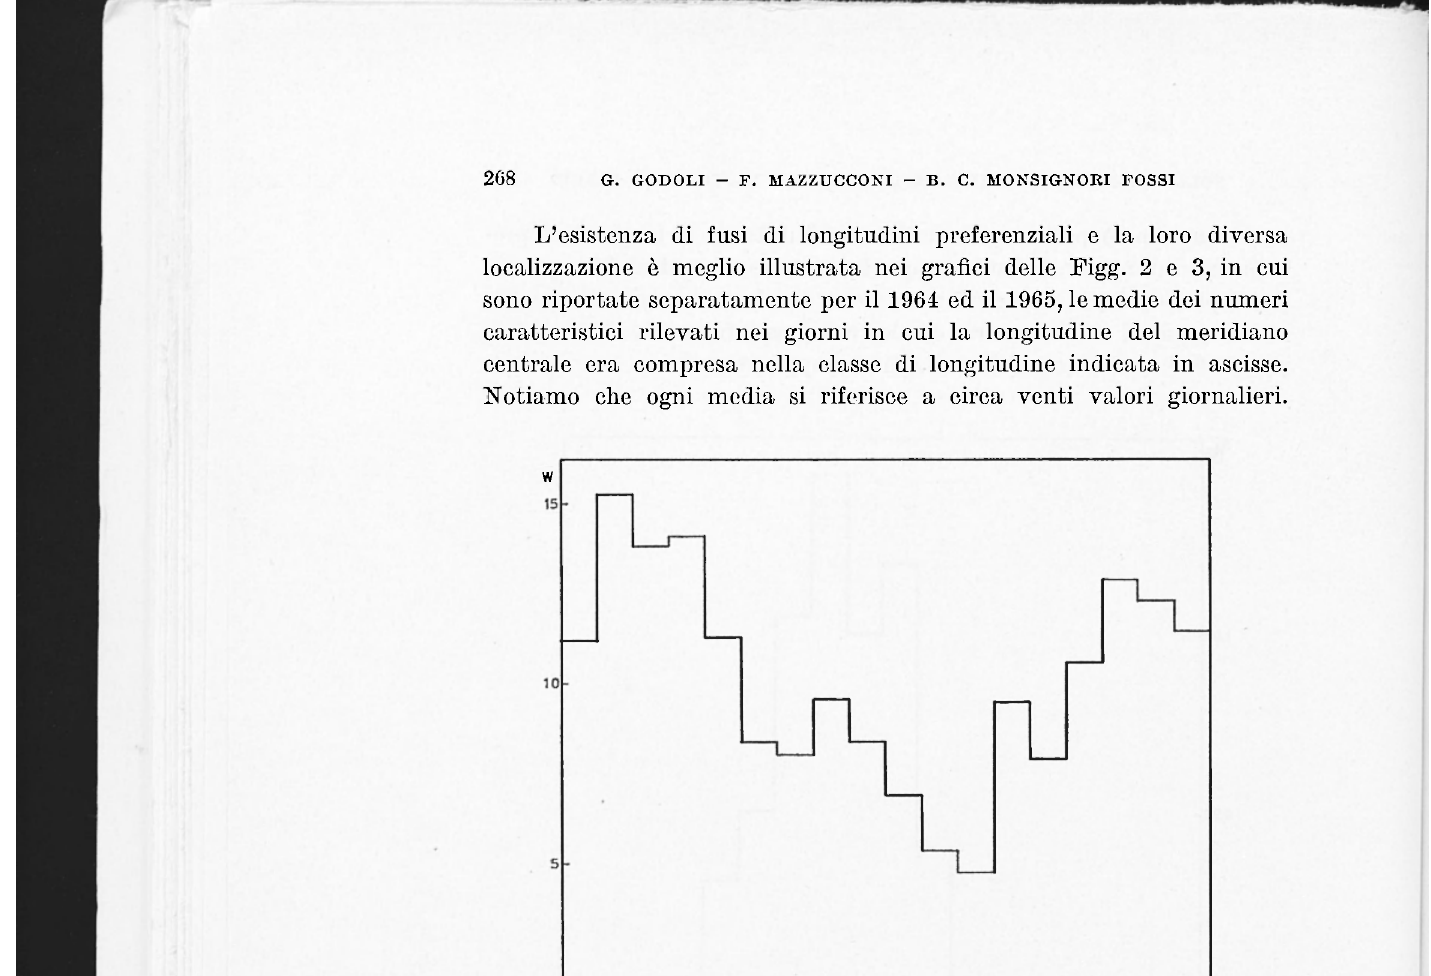
Fig. 4 - Distribuzione in elassi (li 20° (li longitudine delle inedie dei numeri relativi di Wolf per l'anno